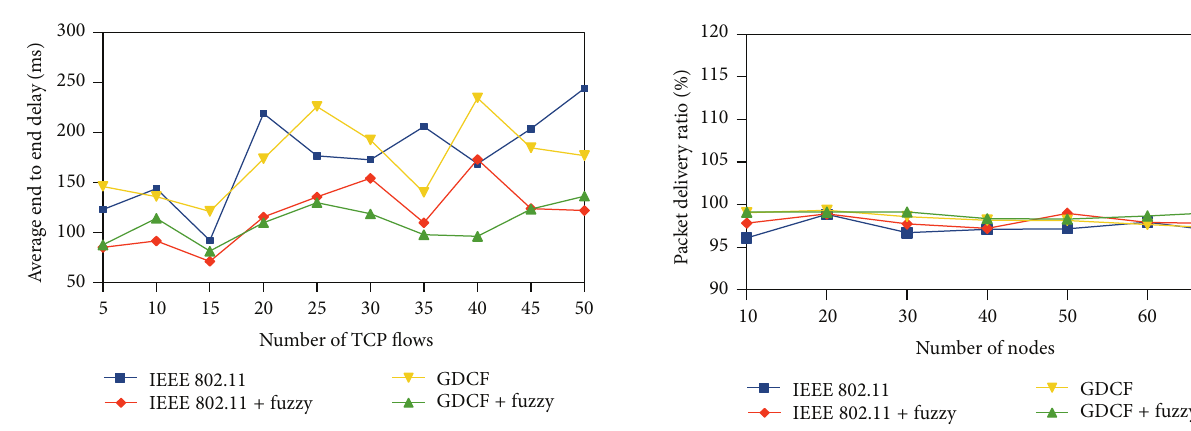
Figure 12: Average end to end delay for 1000 ∗ 1000 scenario.